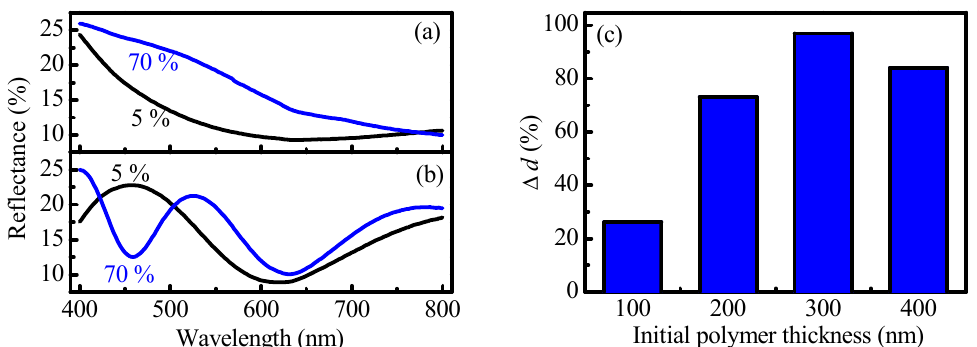
Figure 1. Left: Reflectance spectra at relative humidity (RH) of 5% and 70% of polymer films with initial thickness of 100 nm ( a ) and 300 nm ( b ) deposited on Si substrate; Right: Relative thickness change ∆ d (in percent) of thin polymer films with initial thicknesses in the range 100–400 nm due to the change of humidity from 5% RH to 70% RH ( c ).